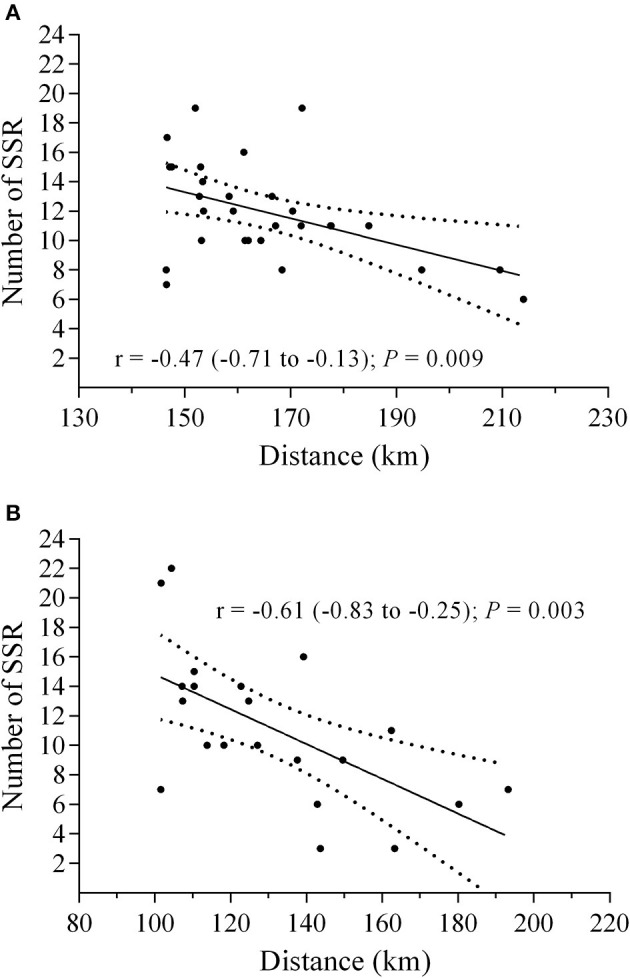
Correlation between number of substantial speed reductions (SSR) and total distance. (A), male (n = 30); (B), female (n = 21).